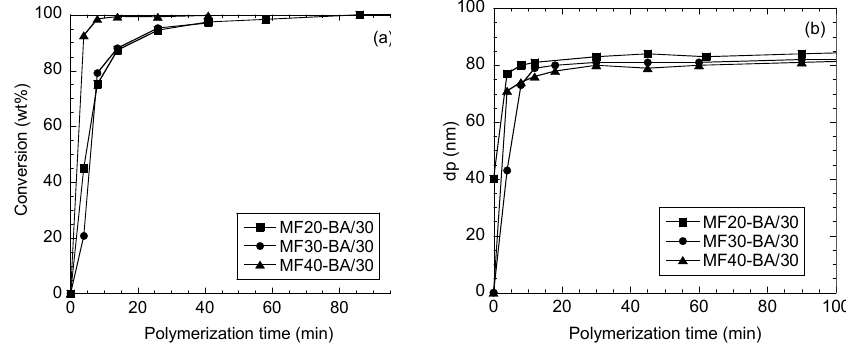
Figure 3. Methacrylate fructose-based copolymers. ( a ) Kinetics and ( b ) particle size evolution for copolymerizations carried out with 1.0 wbm% of KPS.